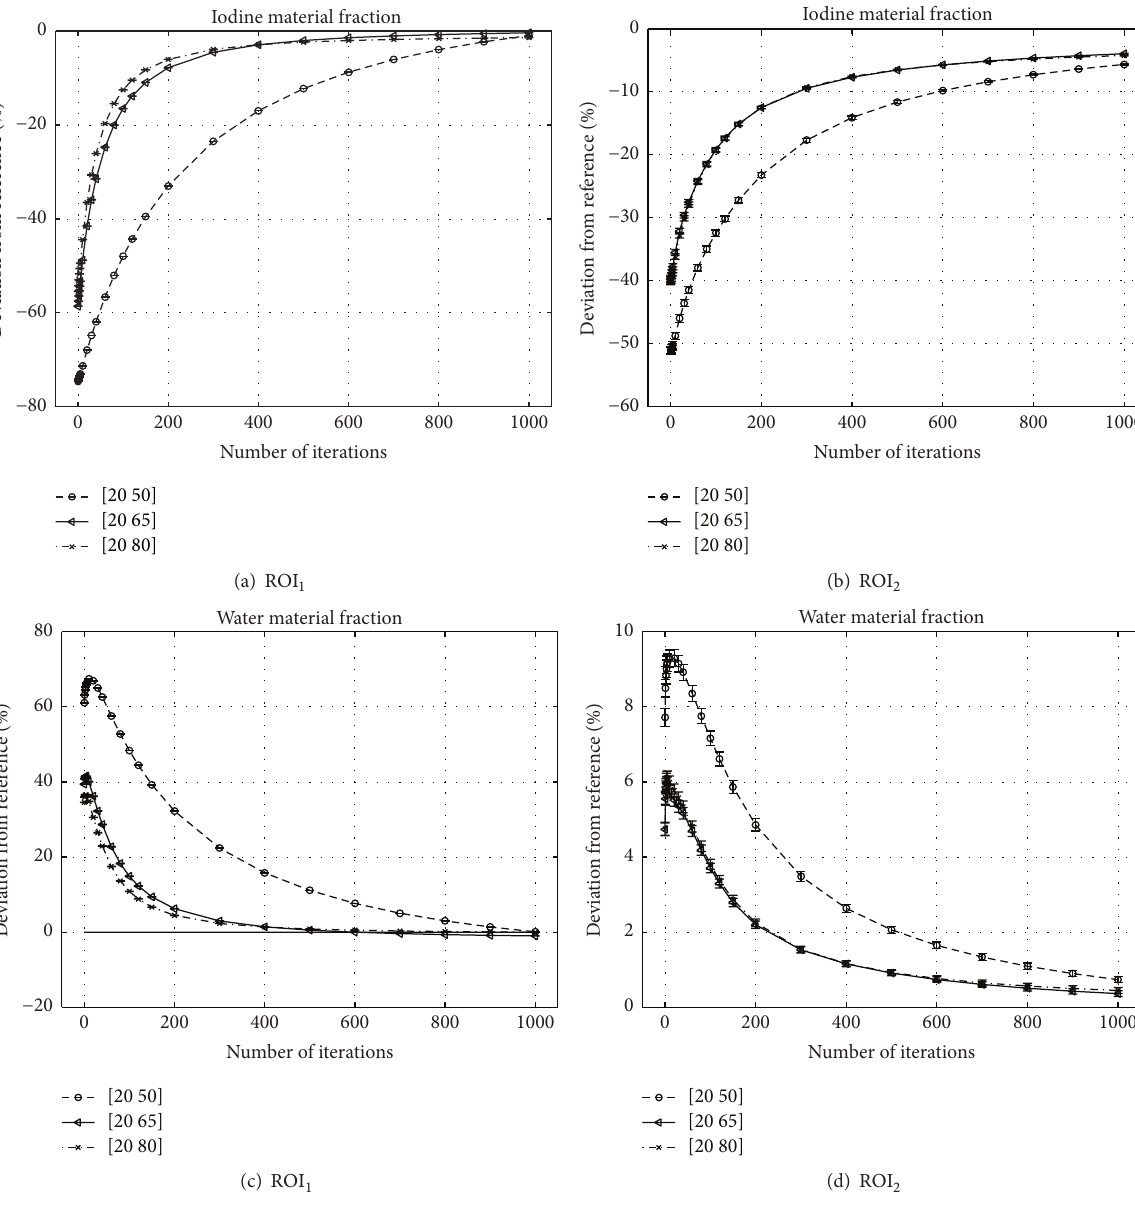
Figure 6: Normalized deviation of the iodine ((a), (b)) and water ((c), (d)) fraction from the ground truth ( Δ𝑓 iodine | water /𝑓 GT ), evaluated within the ROIs shown in Figures 4(a) and 4(b),